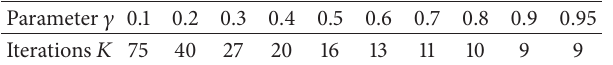
Table 3: The influence of the safety factor parameter 𝛾 on iterations (𝜖 = 0.1 , 𝑥 0 = [1 1 1 1 1 1 1 5] 𝑇 ) .